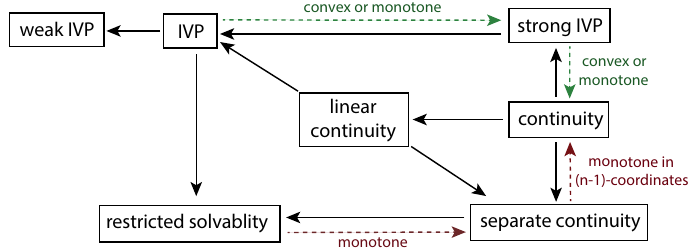
Figure 1. A pictorial representation of Proposition 8, and Theorems 13 and 14 connecting continuity postulates for a